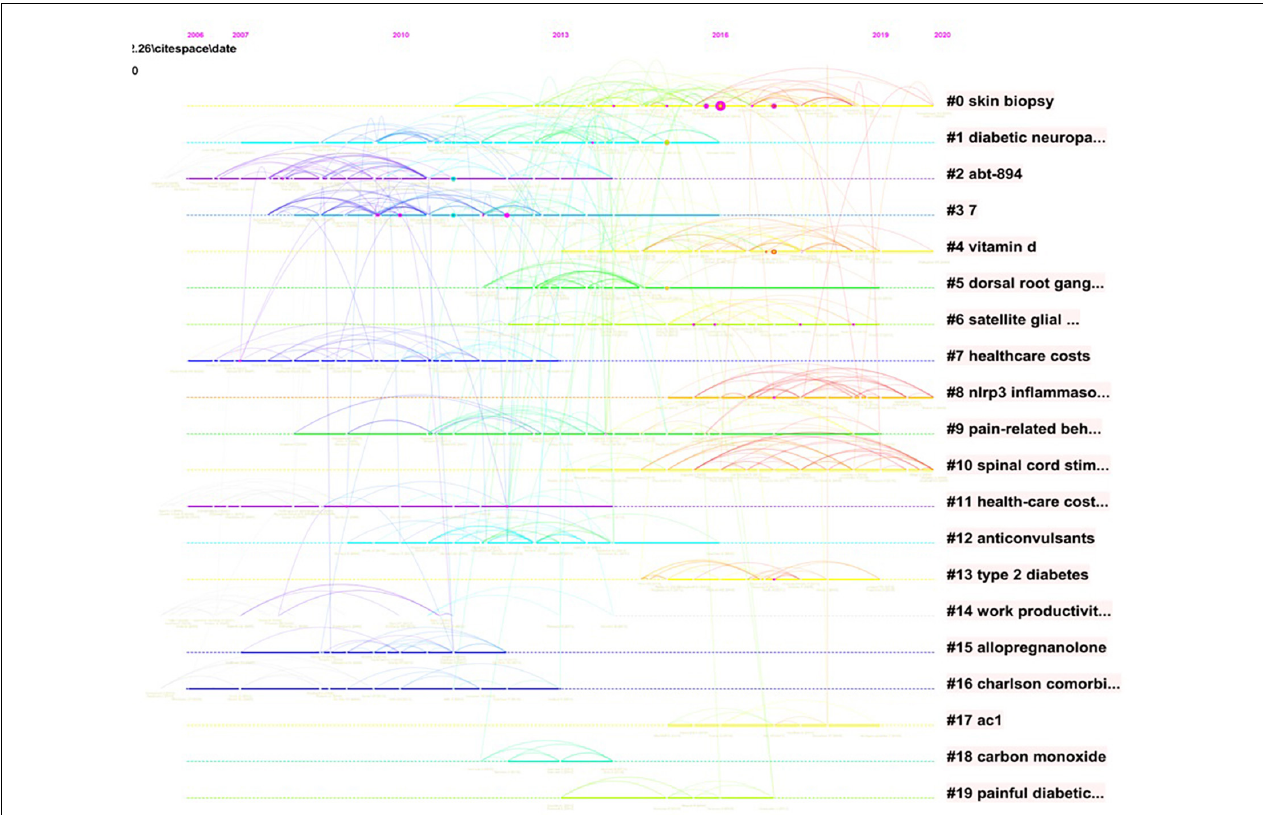
FIGURE 10 | The analysis of references. Co-citation diagram (timeline view) of references from publications on DPNP research.